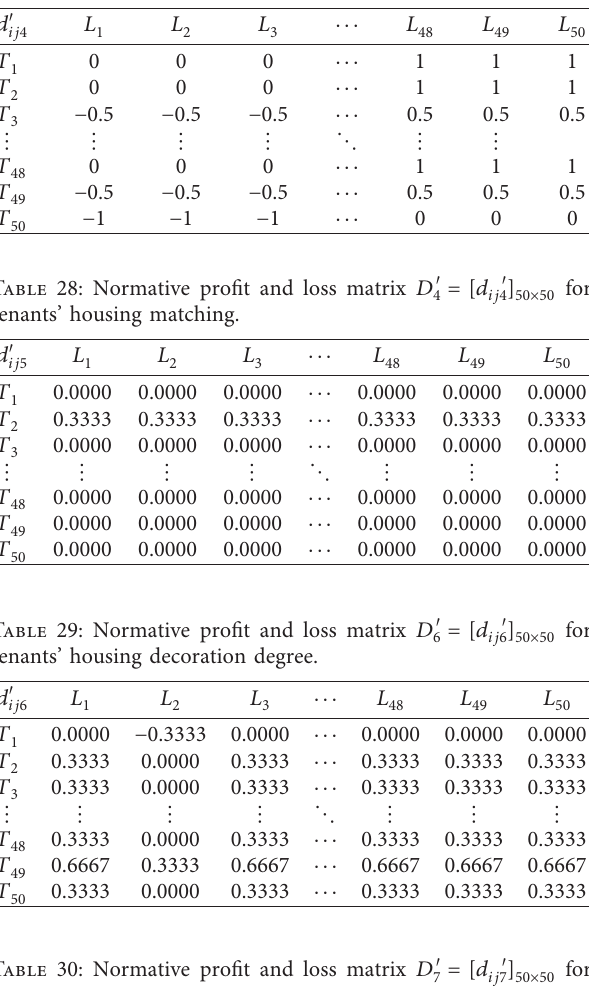
Table 27: Normative profit and loss matrix D tenants’ living room.